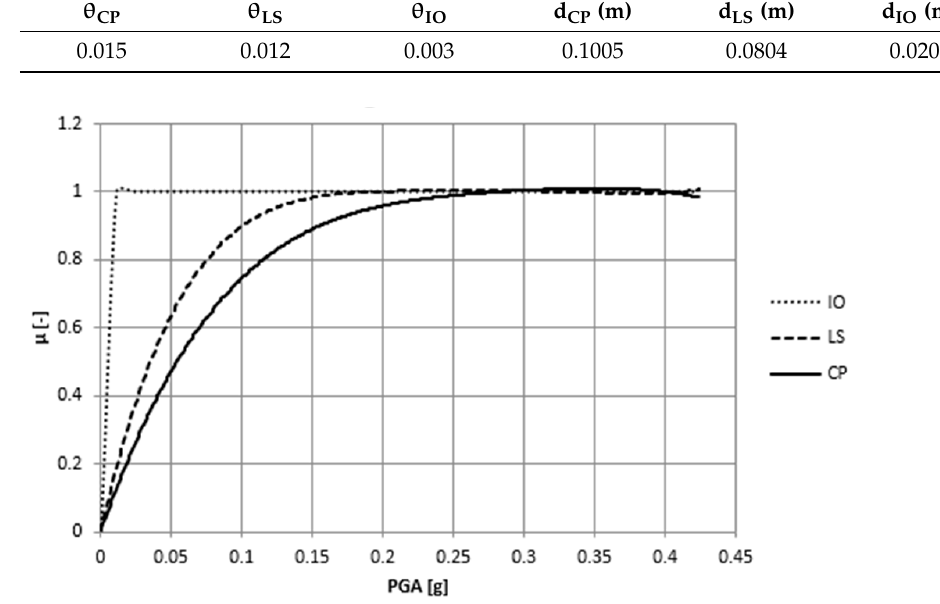
Figure 18. Fragility curves of the intermediate frame in the X -direction with hinged connections.